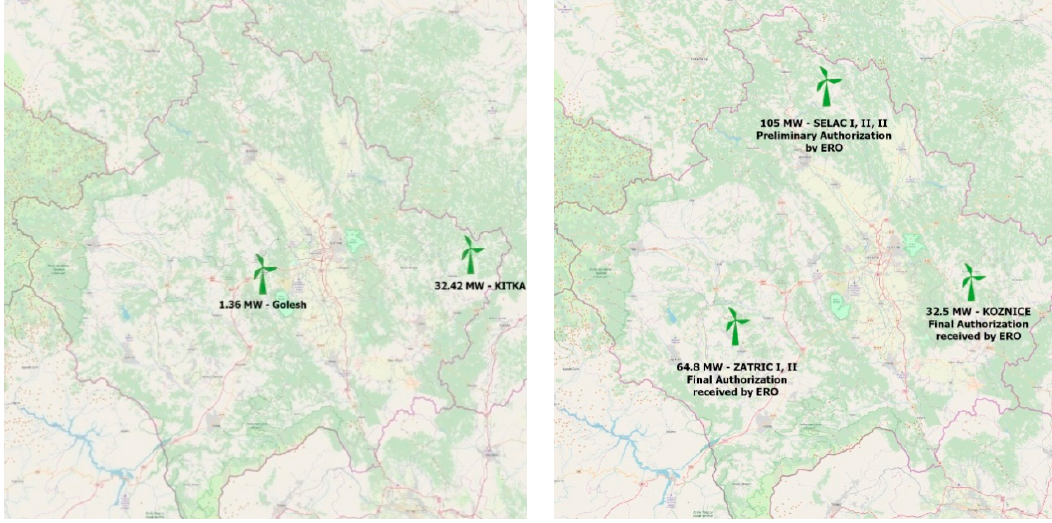
Figure 4. Installed ( left ) and planned ( right ) wind farm plant projects in Kosovo [4]. Table 2. Presentation of projects for wind power generation in Kosovo